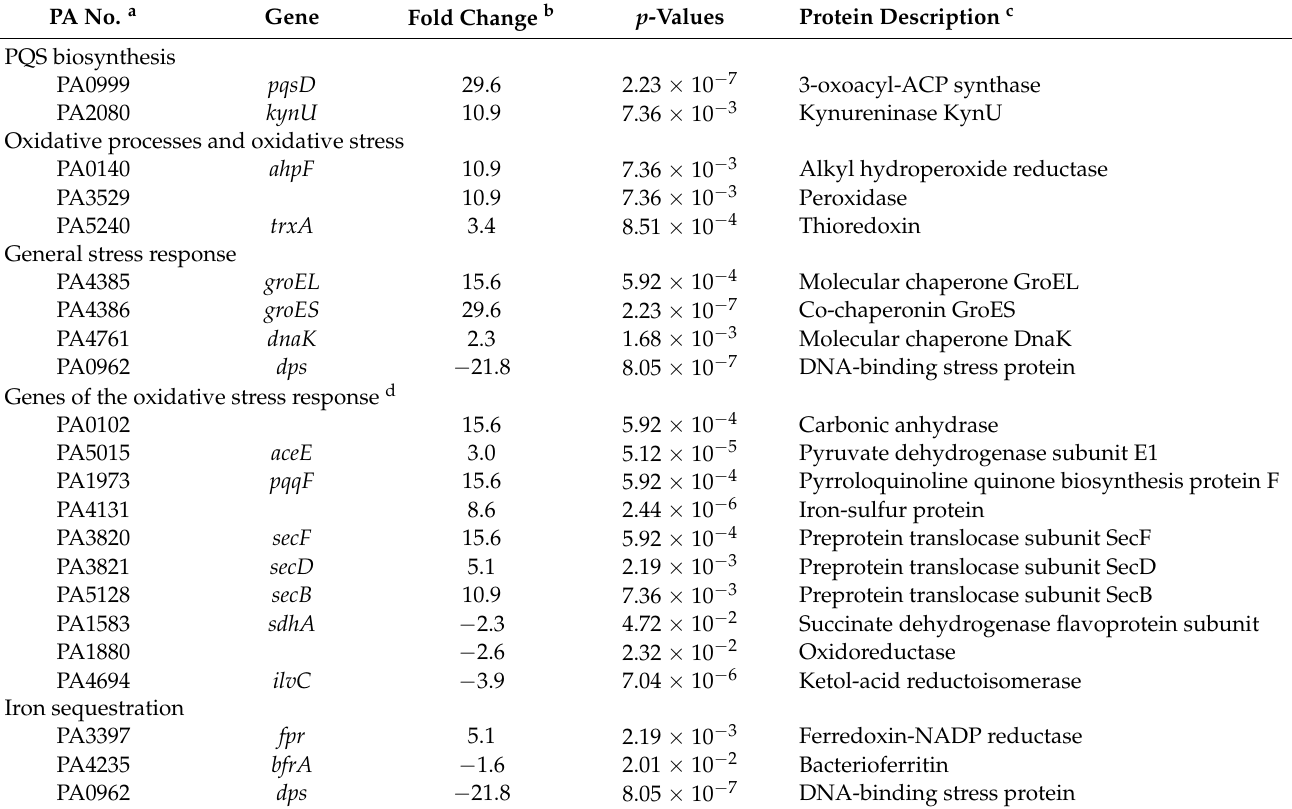
Table 1. Differentially expressed proteins of P. aeruginosa PAO1 compared with the clpV3 mutant identified using quantitative